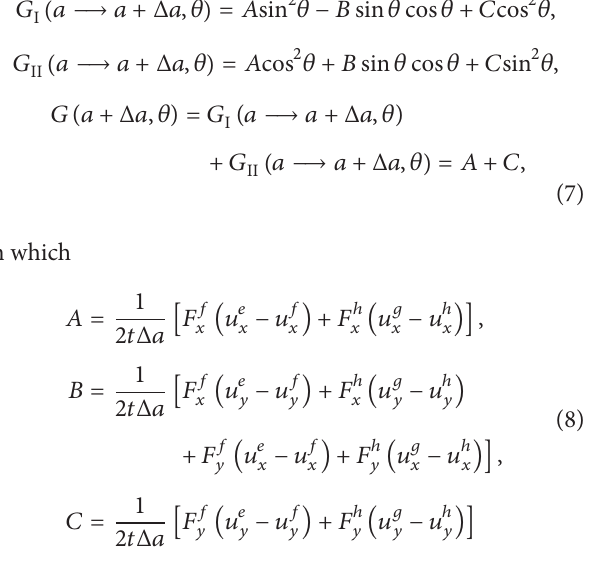
in which 𝐹 𝑖 𝑥 , 𝐹 𝑖 𝑦 (𝑖 = 𝑓, ℎ) are the 𝑥 and 𝑦 components of nodal force at the node 𝑖 before the crack extends by Δ𝑎 , and 𝑢 𝑖 𝑥 , 𝑢 𝑖 𝑦 (𝑖 = 𝑒, 𝑓, 𝑔, ℎ) are the 𝑥 and 𝑦 components of displacement at the node 𝑖 once crack extends by Δ𝑎